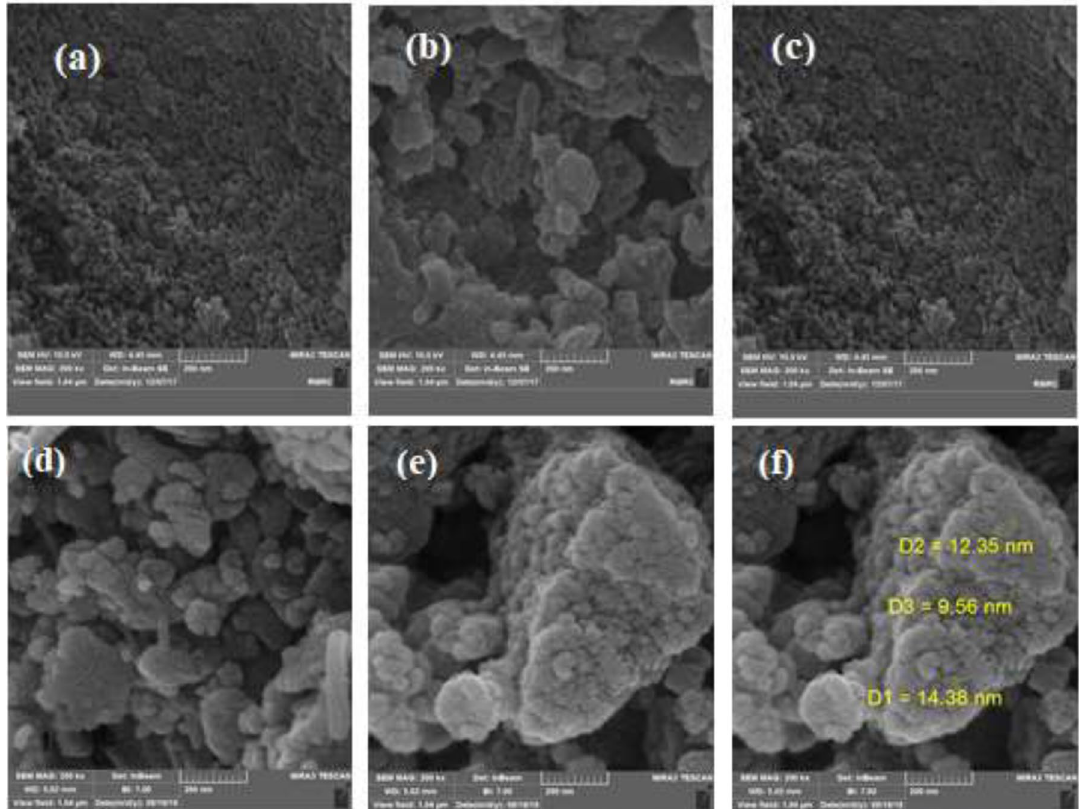
Figure 2. FESEM images of the MCM-41 ( a – c ) and the MCM-41-APS-PMDA-NHSO 3 H ( 1 , d – f )